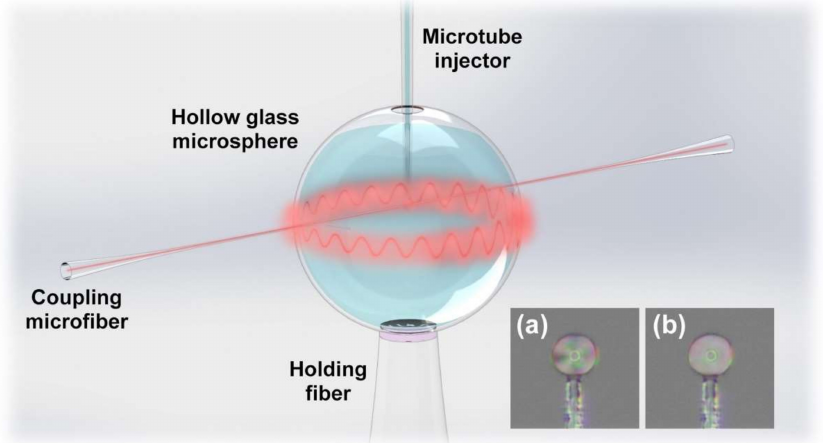
Figure 1. Schematic diagram of the immunosensor based on the prefab HGMS for AMI biomarker detection. Inset: Polarized optical images of the HGMS filled with LC in ( a ) anisotropic and ( b ) isotropic phases.